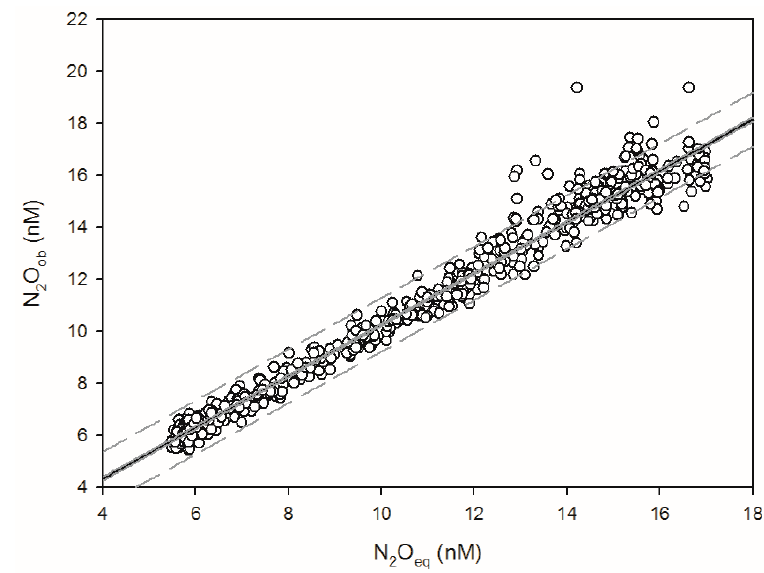
Figure 4. Correlation between observed N 2 O concentration (N 2 O ob ) and equilibrium N 2 O concentration (N 2 O eq ) in the surface water of the 4th Chinese National Arctic Research Expedition and the 27th Chinese Antarctic Research Expedition. A significant correlation ( y = 0.3954 ± 0.0601 + (0.9865 ± 0.0053) x ) between N 2 O ob and N 2 O eq is observed ( p < 0.0001). 3.2. Saturation Anomalies of Different Regions and Their Regulatory Factors